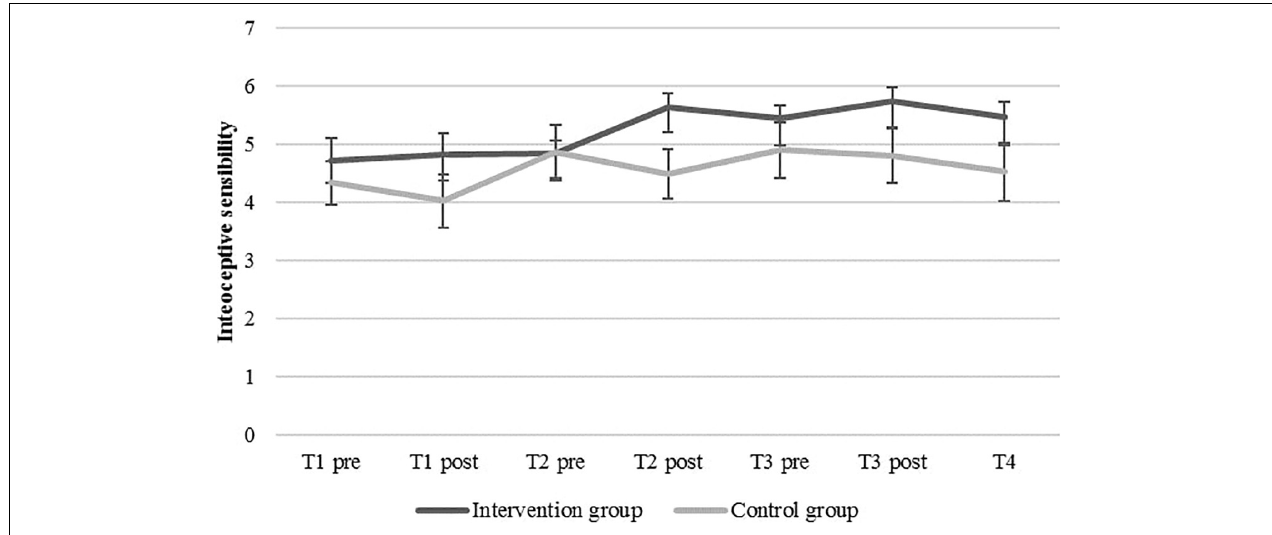
FIGURE 4 | Mean confidence levels (interoceptive sensibility) and standard errors in the intervention and the control group at baseline (T1 pre ), before and after each of the three heartbeat perception training sessions (pre vs. post), and post-measurement (T4).